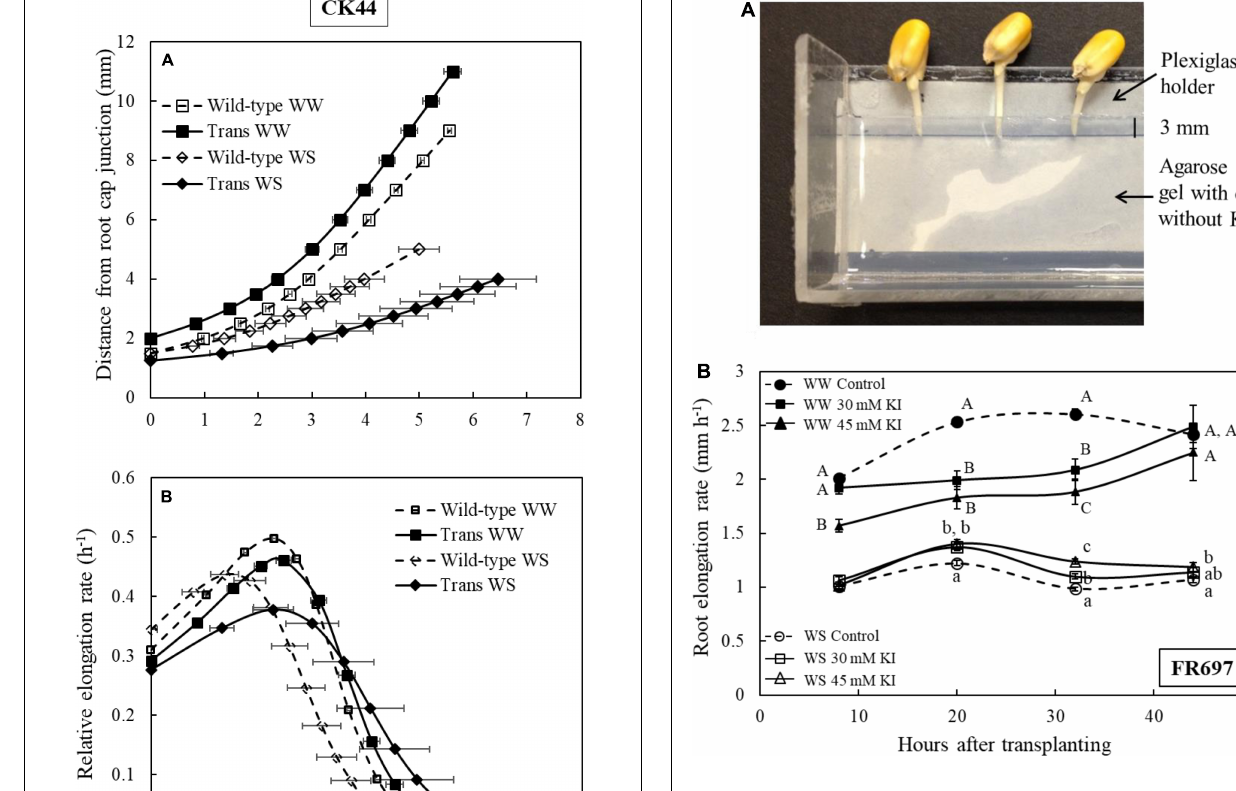
FIGURE 7 | (A) Part of the Plexiglas holder, viewed from above, which was used to pretreat the apical 0–3 mm region of the primary root of line FR697 with the H 2 O 2 scavenger KI. The holder contained a 5-mm thick layer of 1% agarose gel, with or without KI, into which the root tip was inserted. Because the roots elongated during the pretreatment, the kernels were moved away from the gel every 2 h such that only the apical 3 mm of the roots were embedded in the gel. After 6 h, the seedlings were transplanted to well-watered or water-stressed conditions. (B) Elongation rates of control and KI-pretreated (30 or 45 mM) primary roots after transplanting to well-watered (WW) or water-stressed (WS; –1.6 MPa) conditions. The elongation rates are plotted at the midpoint between marking intervals, which were at 0, 16, 24, 40, and 48 h after transplanting. Data are means ± SE of three independent experiments ( n = 15–40 seedlings per treatment in each experiment). Different letters denote significant differences between treatments at specific times within each condition ( t -test; P <